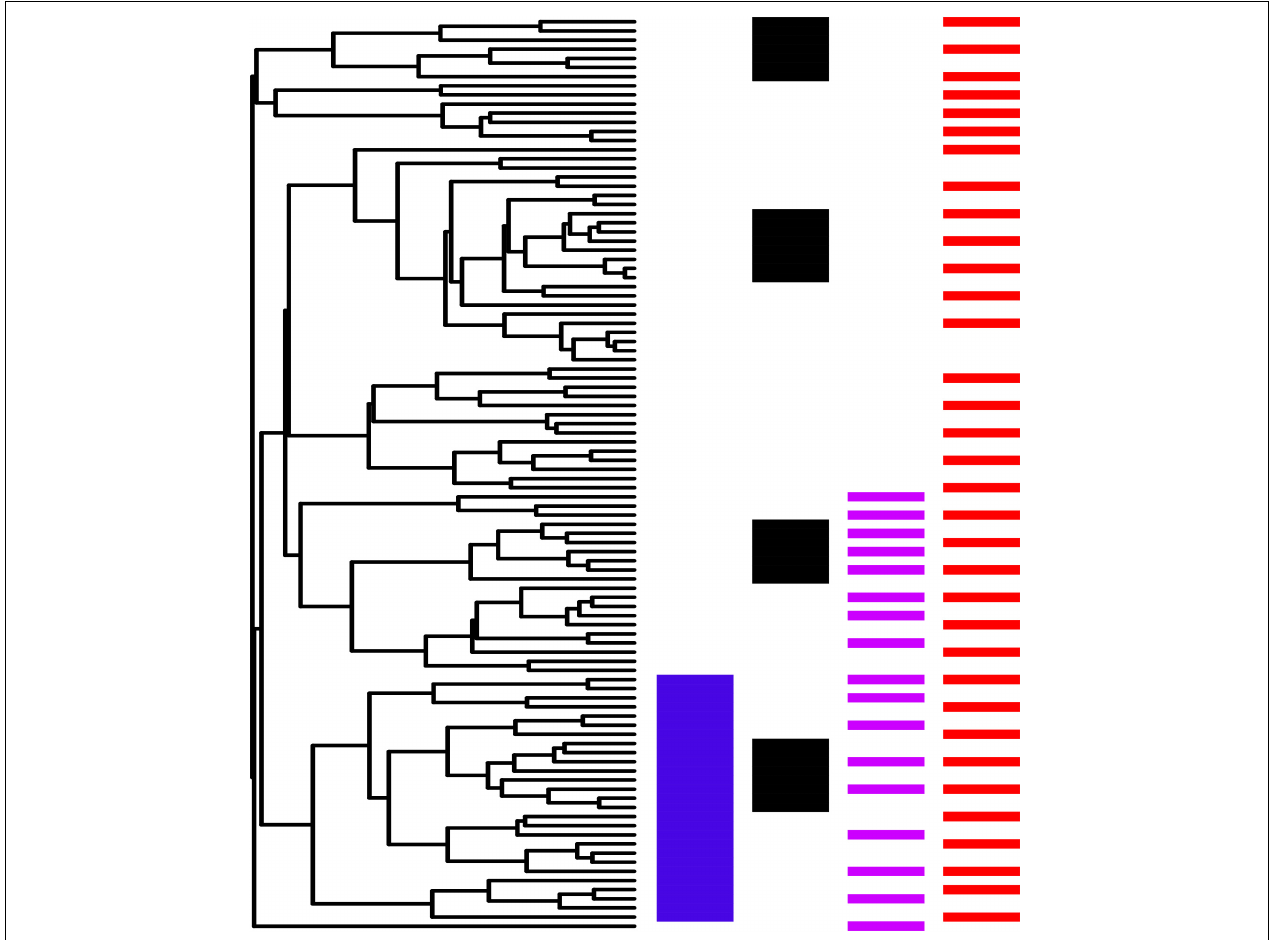
FIGURE 1 | Schematic representation of scenarios of relatedness. Clustering and overdispersion are inferred from MPD and MNTD values (and their related NRI and NTI indices respectively). MPD describes relationships that occurred on deep nodes of the phylogeny, while MNDT reflects relationships at shallower nodes. Combined values can be used to infer different scenarios. Blue, phylogenetic clustering, MPD and MNTD positive; black, overdispersion of clustering, MPD negative and MNTD positive; pink, clustering of overdispersion, MPD positive and MNTD negative; red, phylogenetic overdispersion, MPD negative and MNTD negative. The phylogenetic tree was generated with the function “rtree” from the package ape using